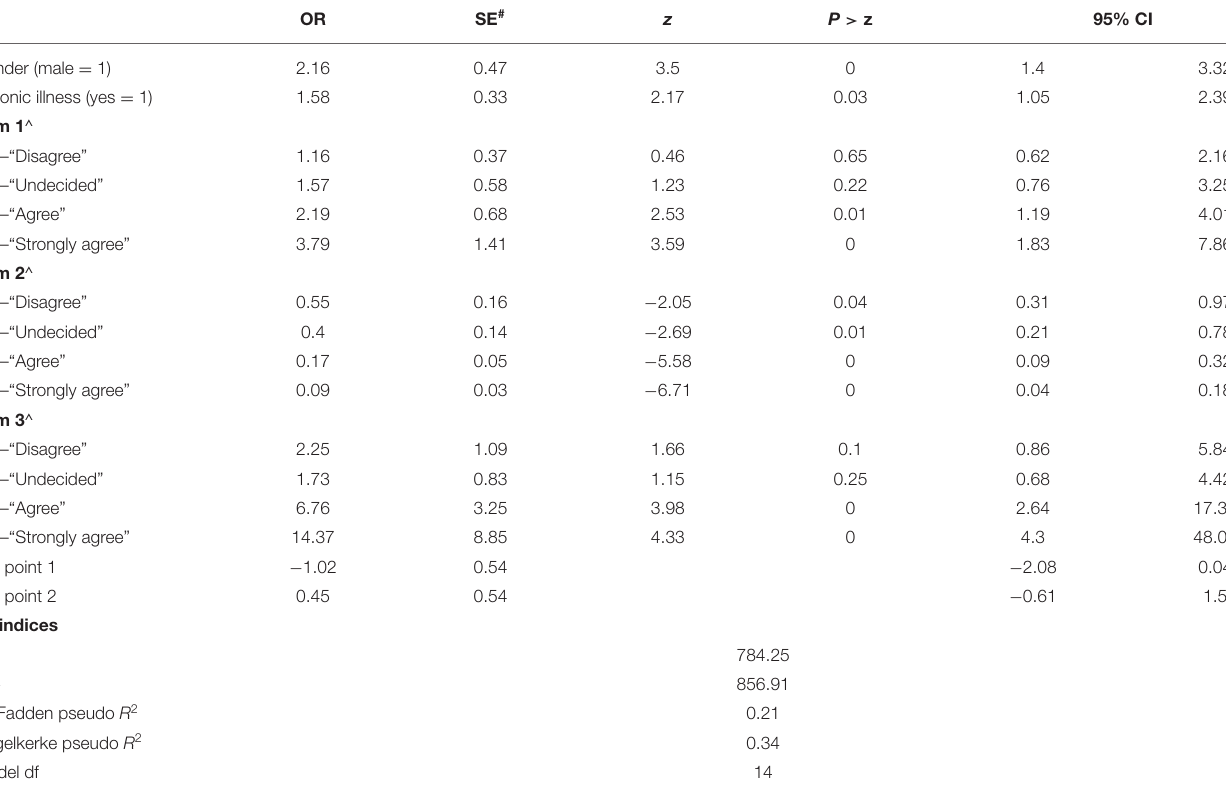
TABLE 4 | Results of OLR model predicting willingness to use telemedicine in the future (0 = “Disagree,” 1 = “Neutral,” and 2 = “Agree”) ( N =